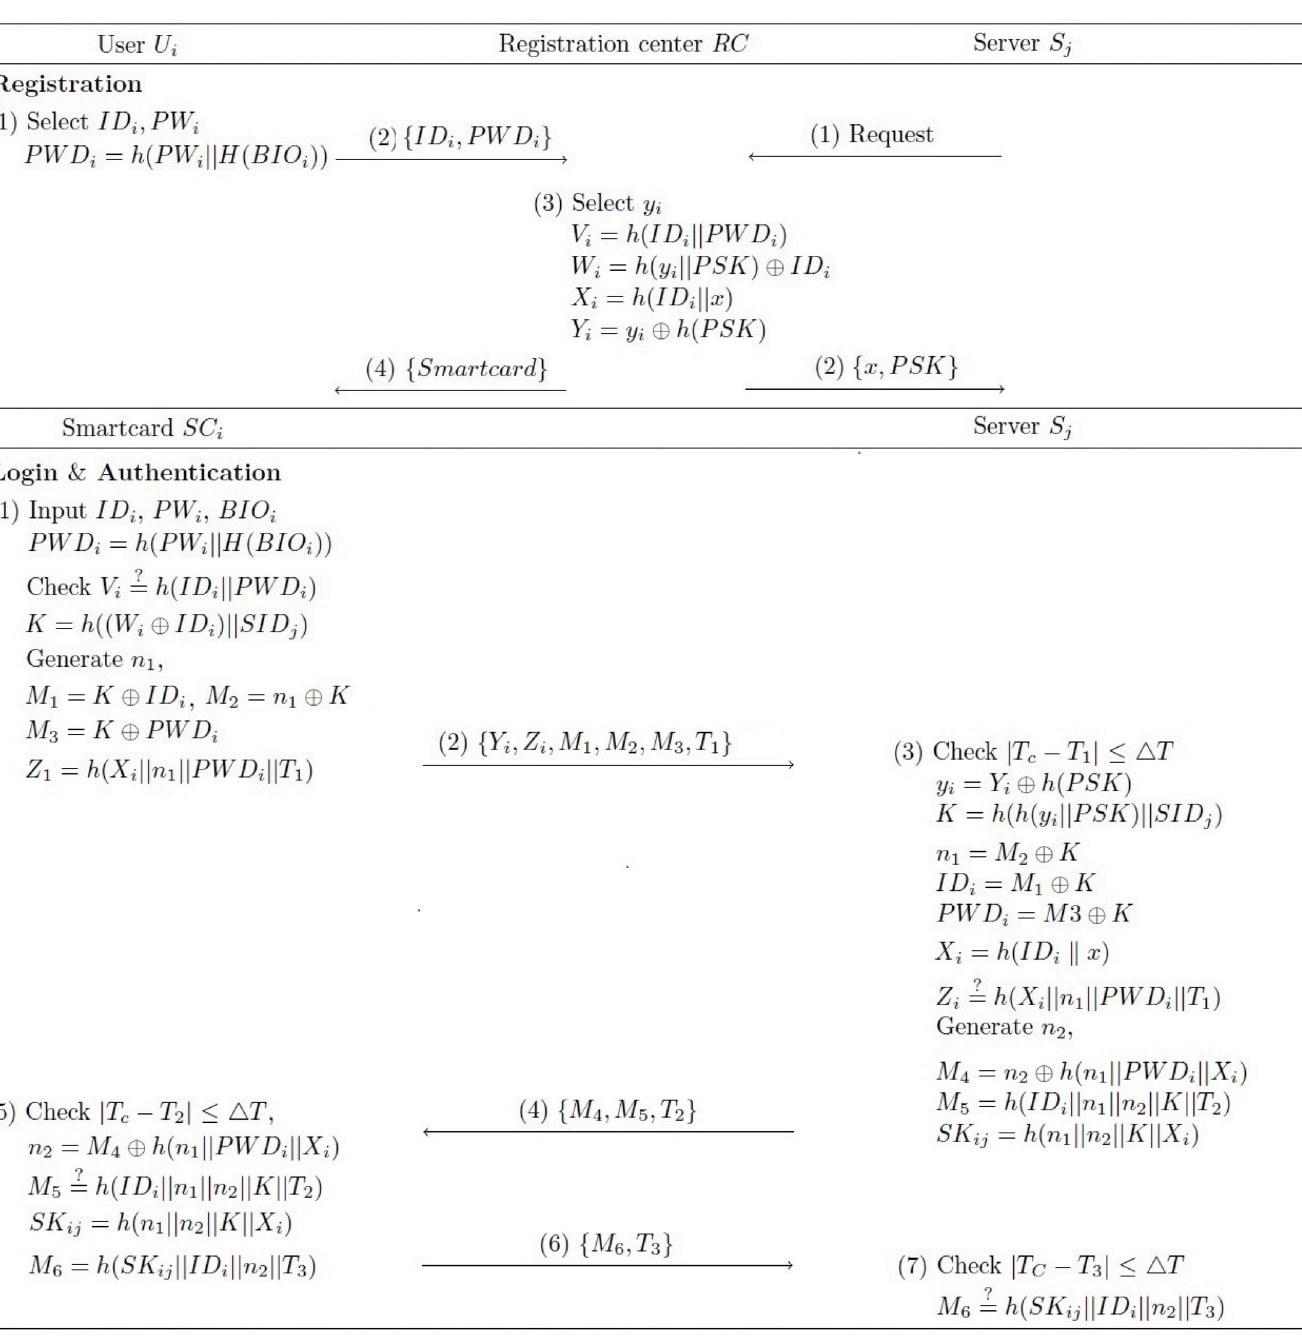
Fig 1. Our proposed authentication and key agreement protocol for multi-server